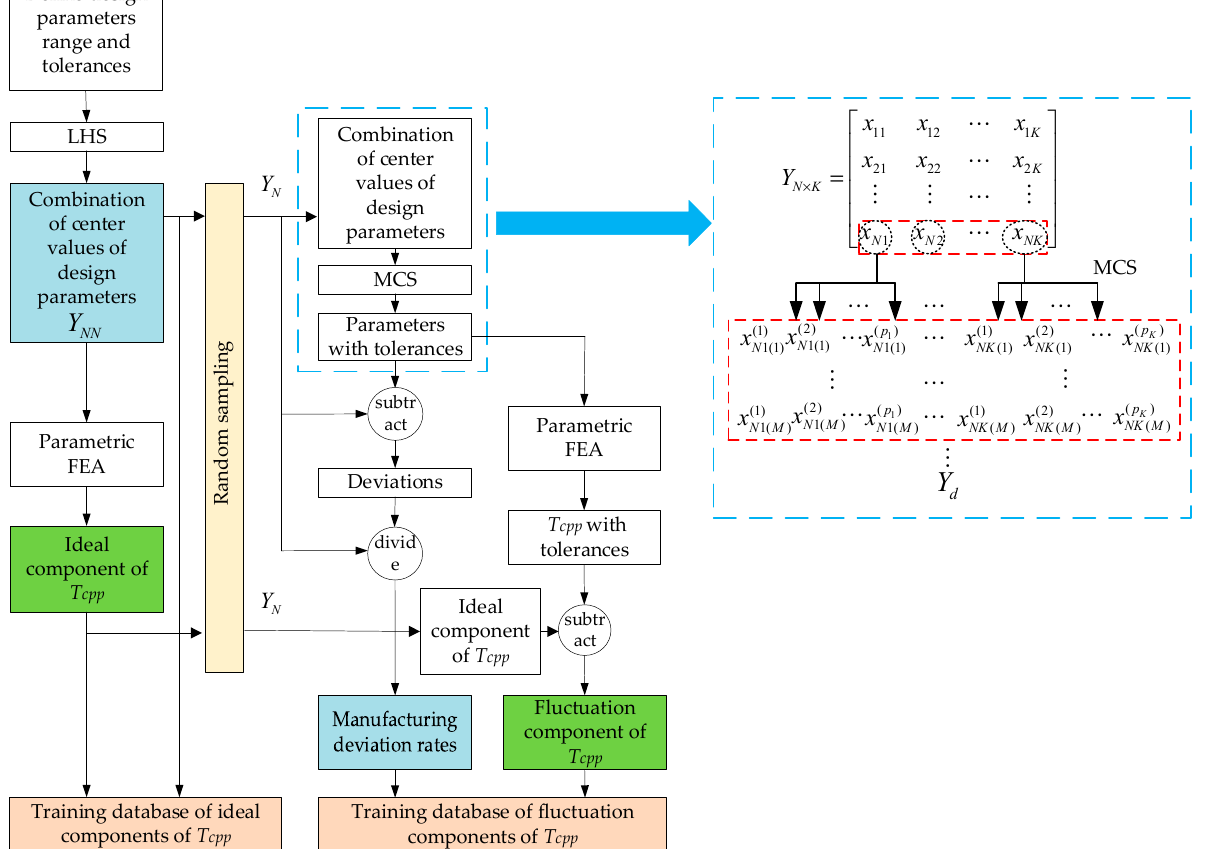
Figure 4. The procedure of establishing the training database.